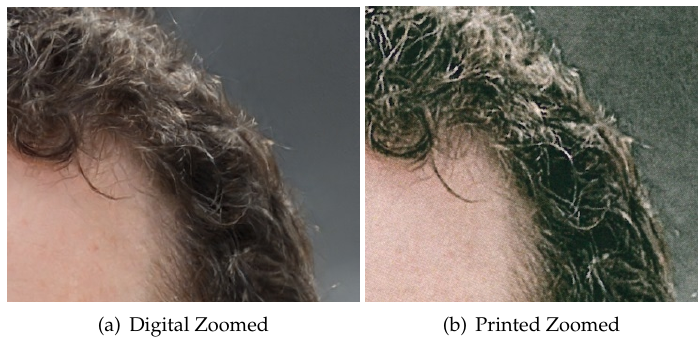
Figure 4. A StyleGAN2 generated image in its original and printed–scanned versions.